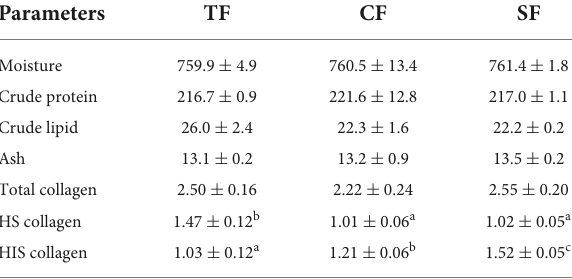
TABLE 4 Flesh composition of largemouth bass fed trash fish and formula feeds (fresh tissue, g/kg). 1